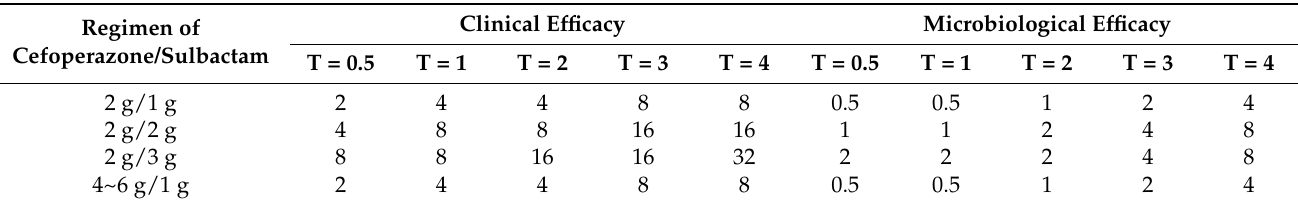
Table 7. Cutoff based on PTA(%T > MIC cpz )*PTA(%T > MIC sul ) (mg/L). Dosing frequency was q8h. Regimen